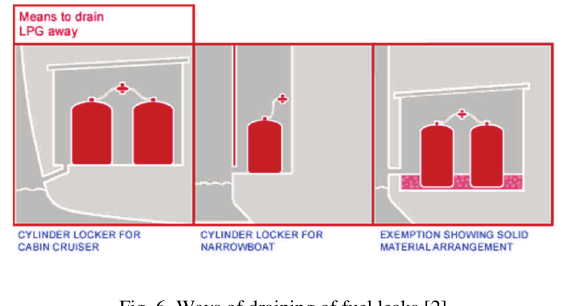
Fig. 6. Ways of draining of fuel leaks [2]